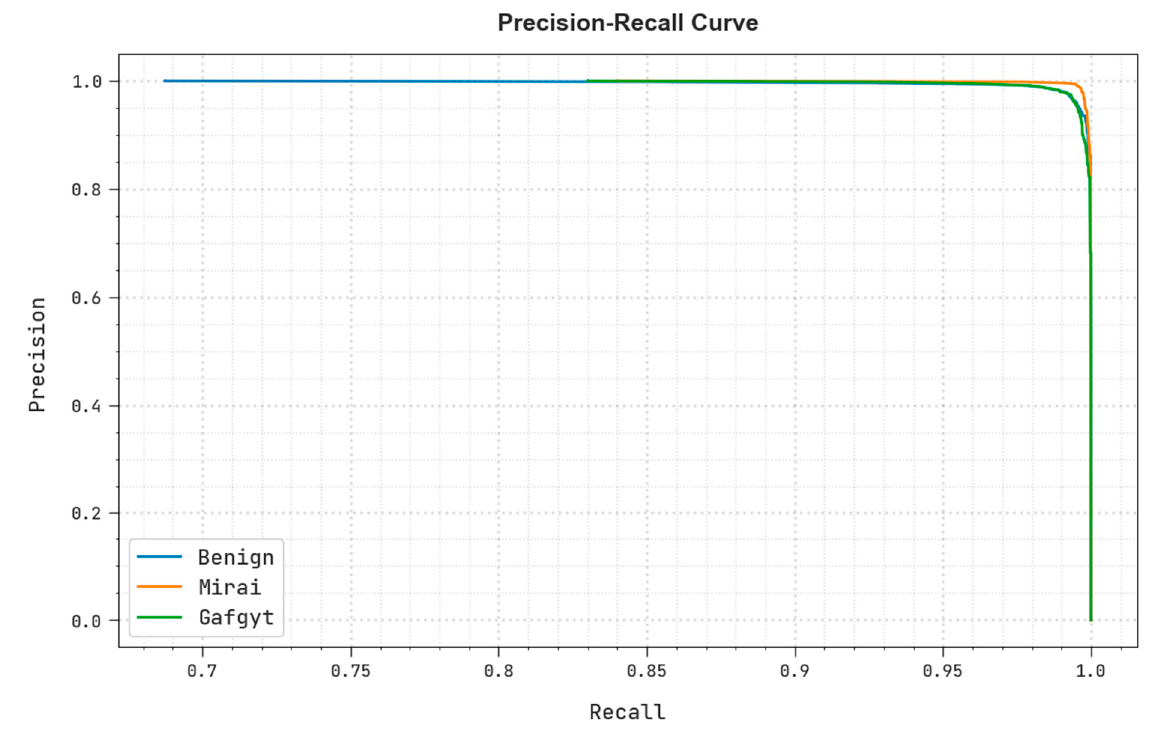
Figure 9. Precision-recall curve analysis for BND-BMOML algorithm.